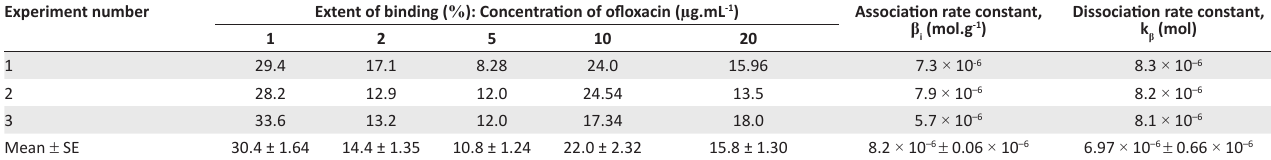
TABLE 2: In vitro binding of ofloxacin with plasma proteins and kinetic constants in water buffalo calves at various drug concentrations. Experiment number Extent of binding ( % ): Concentration of ofloxacin ( µ g.mL -1